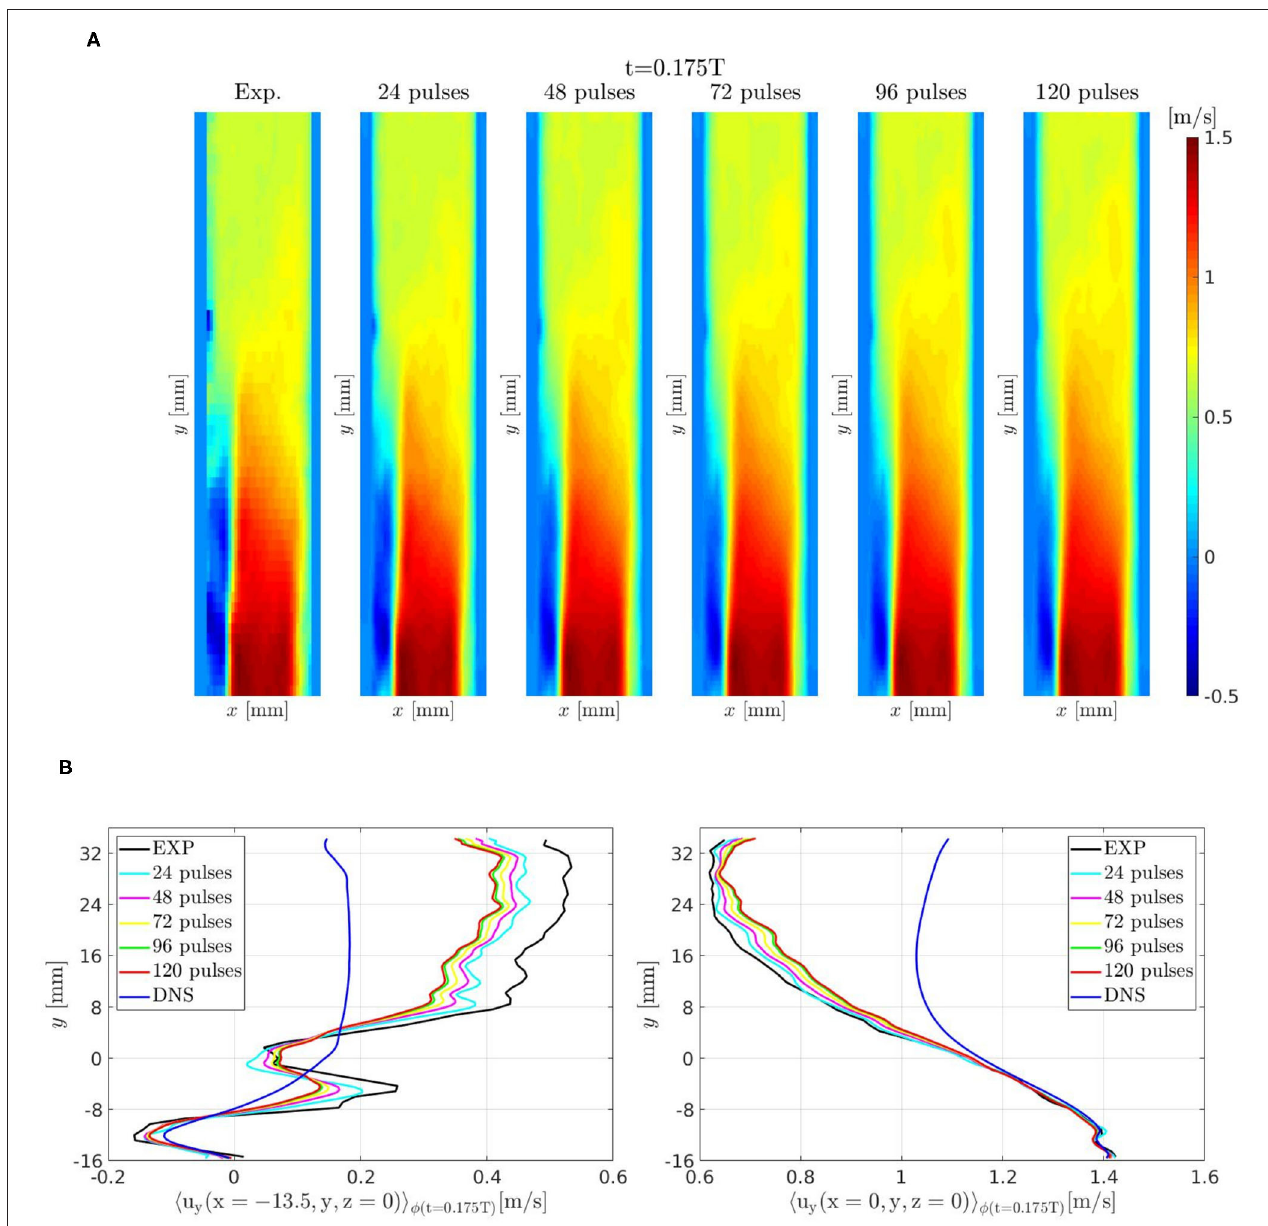
i φ obtained by the DA algorithm for x , y , z = 0, t φ = 0.175 T (cid:0) (cid:1)